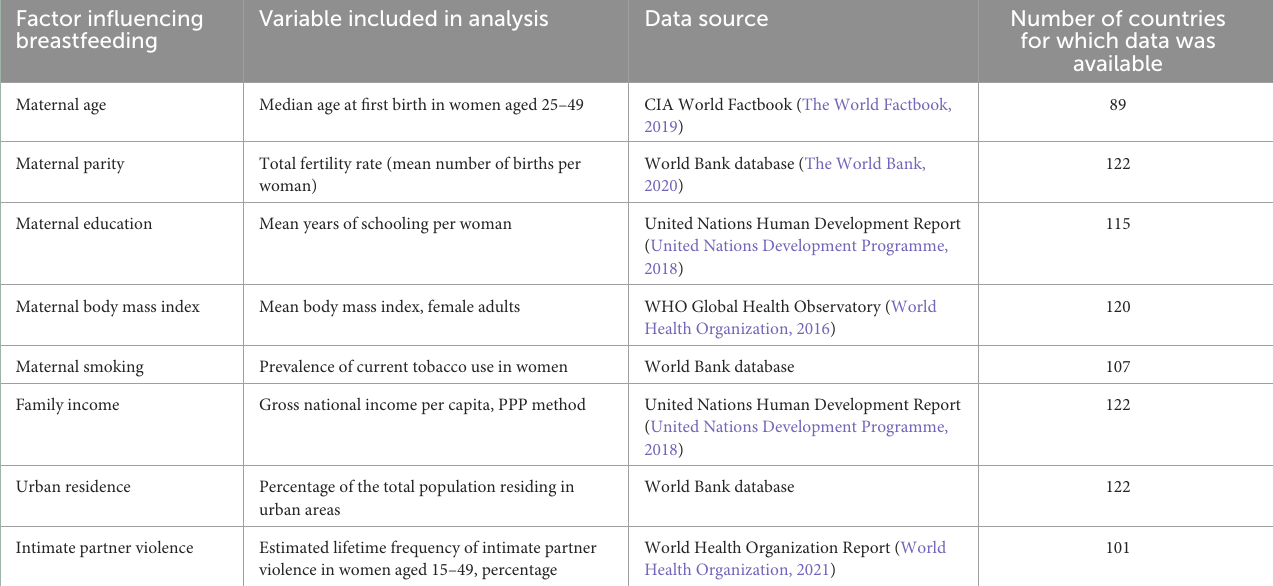
TABLE 2 Confounding factors influencing breastfeeding initiation and maintenance examined in this study, with their data sources. Factor influencing